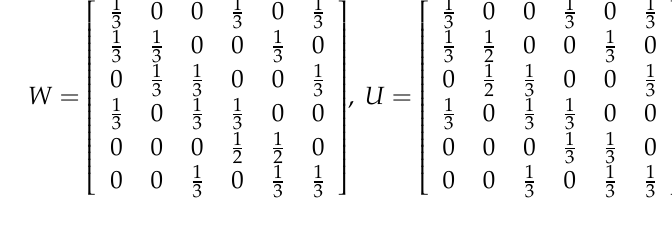
Figure 8. The optimal consensus variable λ i ( a ), Mismatch y ( b ), DGs output power x i ( c ), the sum of x i ( d